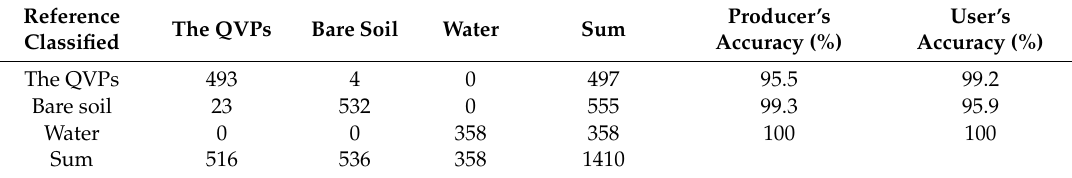
Table 4. Confusion matrix showing the producer’s and user’s classification accuracies for three land cover classes obtained from the selected early spring (27 March 2017) predictive variable datasets.